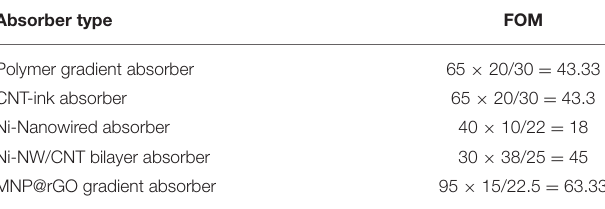
TABLE 2 | Comparison of figure of merit (FOM) defined by Equation (5). Absorber type FOM